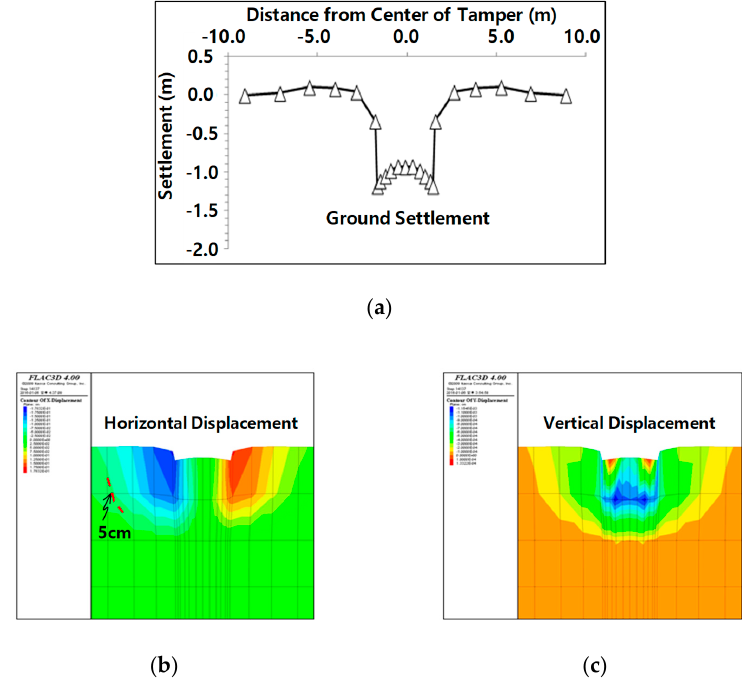
Figure 10. Horizontal and vertical displacement due to compaction (D = 4 m, W = 20 tons, N = 12, H = 15 m): ( a ) ground settlement distribution; ( b ) horizontal displacement contour; ( c ) vertical displacement